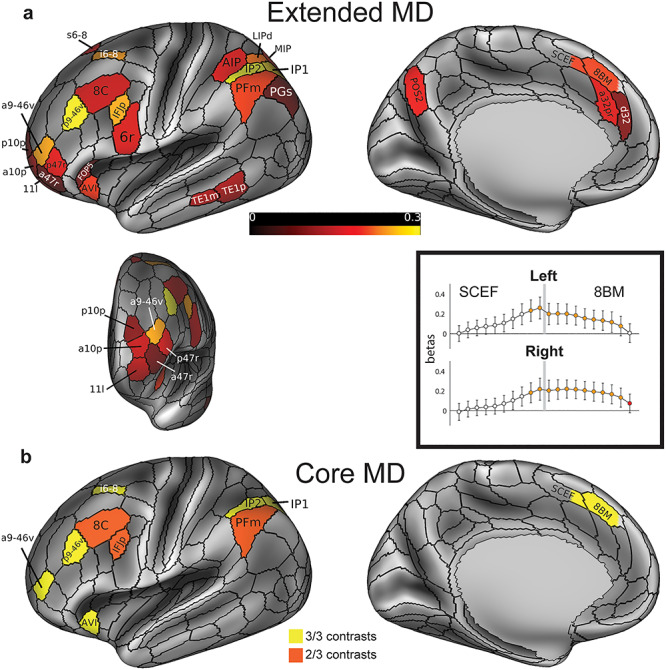
(a) The extended MD system: conjunction of significant areas across three functional contrasts. Areal colors reflect average beta values across the three contrasts analyzed in relation to subject-specific parcellations. Data are averaged across hemispheres and for illustration projected here onto the left lateral and medial surfaces (top) and an anterior view of frontal pole parcels (bottom left). Box (bottom right) displays pattern of activity in regions SCEF (posterior) and 8BM (anterior), divided into posterior to anterior segments in relation to subject-specific parcellations. Gray bar indicates 8BM/SCEF border. Orange indicates segments that are part of the extended MD system when activity from both hemispheres is combined (i.e., segments with activity significantly above zero in all three behavioral contrasts). Red indicates one additional segment that survives as part of the extended MD system when activity from each hemisphere is tested separately. (b) The core MD system: areas with activity estimates that were significantly higher than the mean activity of all extended MD areas in all three contrasts (yellow) and two out of three contrasts (orange). Data available at http://balsa.wustl.edu/qNLq8.